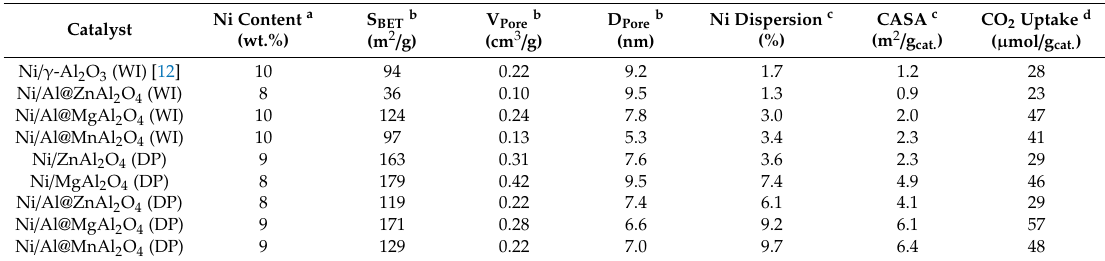
Table 1. Textural properties of Ni-supported